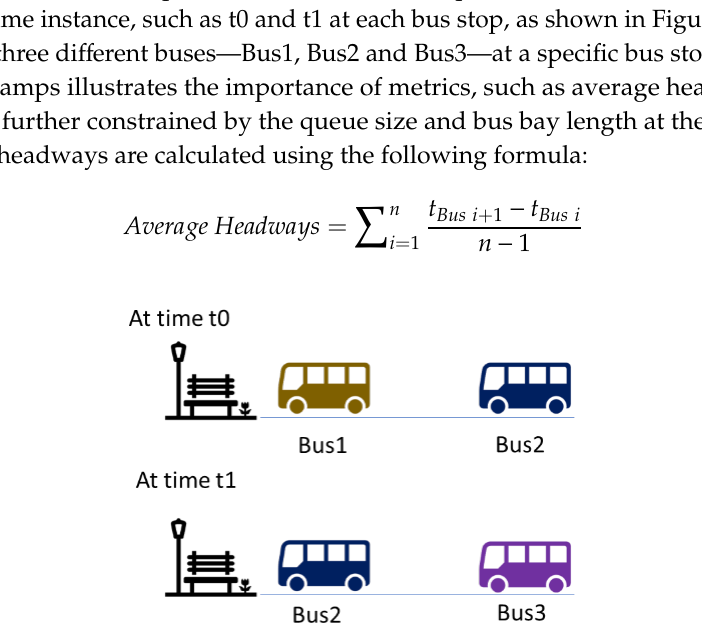
Figure 11. Bus arrival at a bus stop for different time instances.